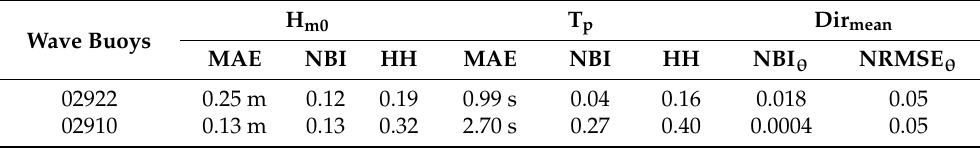
Figure 5. Times series of measured and computed significant wave height H m0 , peak period T p and mean wave direction Dir mean (anticlockwise convention from east) between April and December 2019 at wave buoy 02922 in the western part of domain R1. Table 1. Statistics for the evaluation of the significant wave height H m0 , peak period T p and mean wave direction Dir mean at the two wave buoys considered. Statistics at wave buoy 02922 were computed for the year 2019 (from end of March to the end of the year) whereas statistics at wave buoy 02910 were computed from 1 January 2006 to 1 March 2015 in relation to the availability of in situ measurements at these two locations. Further details about the mathematical formulations of these metrics are available in Section 3.4. Please also note that, with an exception for the mean absolute error (MAE), these metrics correspond to normalised parameters.